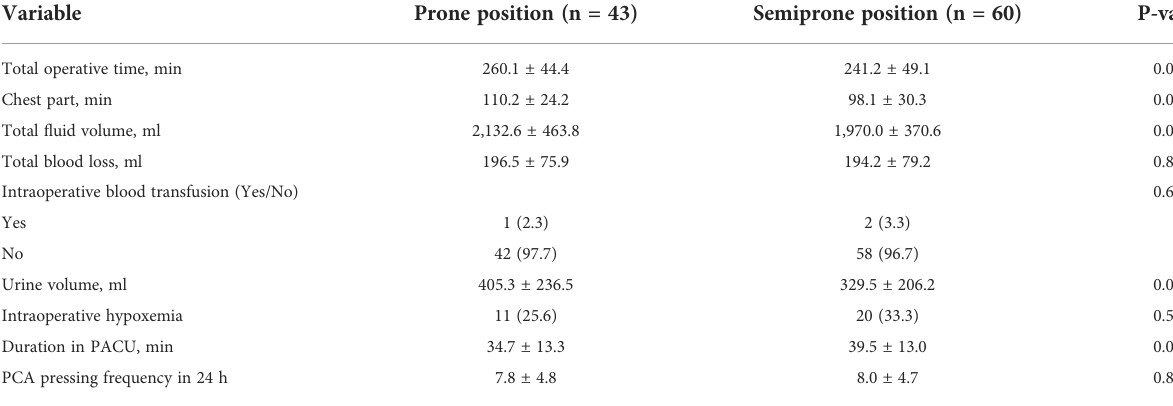
TABLE 2 Intraoperative surgical outcomes.